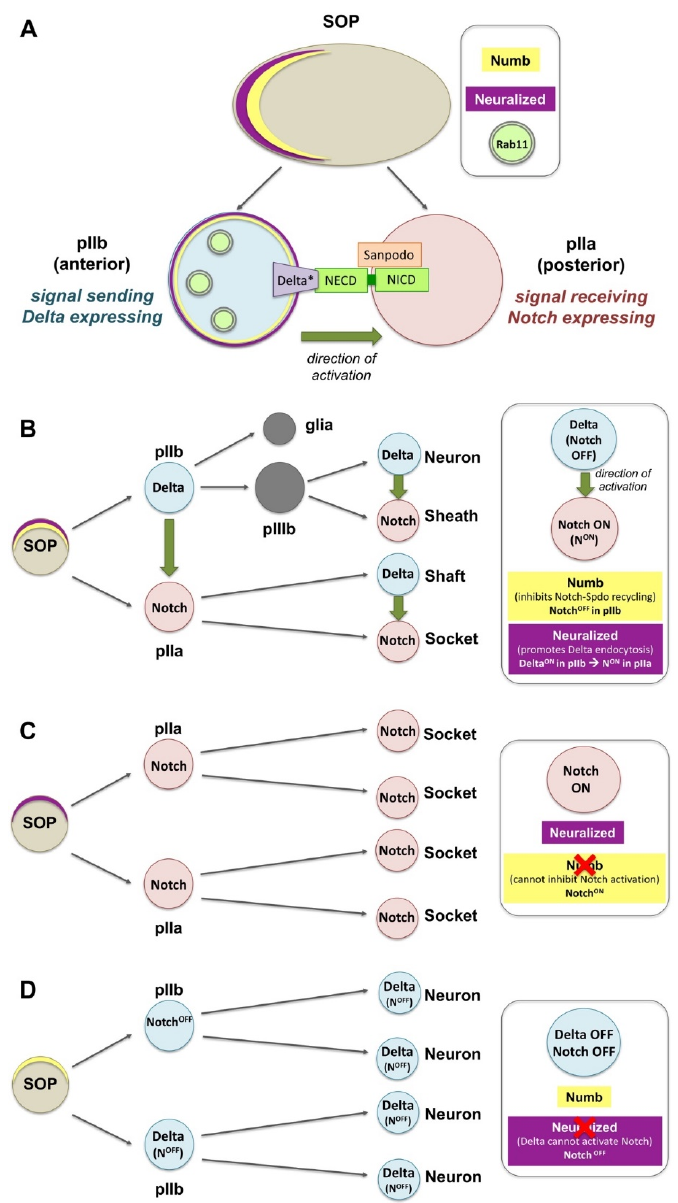
Figure 2. Notch activation and asymmetric distribution of fate determinants in Drosophila sensory organ precursors (SOPs). ( A ) The differential activation of Notch relies on the asymmetric distribution of the cell fate determinants Neuralized (Neur) and Numb in the anterior side of the SOP. Upon division, Neur and Numb get segregated into the pIIb. Numb inhibits the recycling of Notch and Sanpodo (Spdo) directing them to degradation. Neur promotes the ubiquitination and endocytosis of Delta, and thereby its activation (Delta*). Delta* recycles to the membrane via Rab11 recycling endosomes, so that it can bind the extracellular domain of Notch (the internalization events for Notch, Spdo and Delta are not shown in this diagram). ( B ) SOPs are polarized epithelial cells that divide asymmetrically to give rise to a posterior pIIa and anterior pIIb. The latter divide further to generate a neuron, a sheath, a shaft, and a socket. ( C ) Loss of numb can no longer inhibit Notch-Spdo recycling in the anterior pIIb where Notch now stays active, and all cells adapt the socket fate. ( D ) Loss of neur can no longer activate Delta in pIIb, Notch is not activated in the pIIa and all cells give rise to neurons.